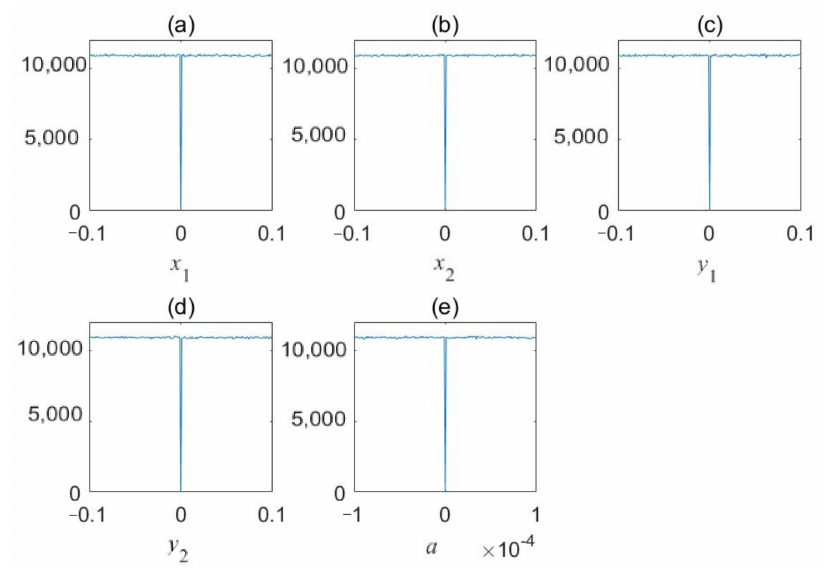
Figure 20. MSE analysis of encryption process of Baboon image: ( a ) x 1 ; ( b ) x 2 ; ( c ) y 1 ; ( d ) y 2 ; ( e ) a